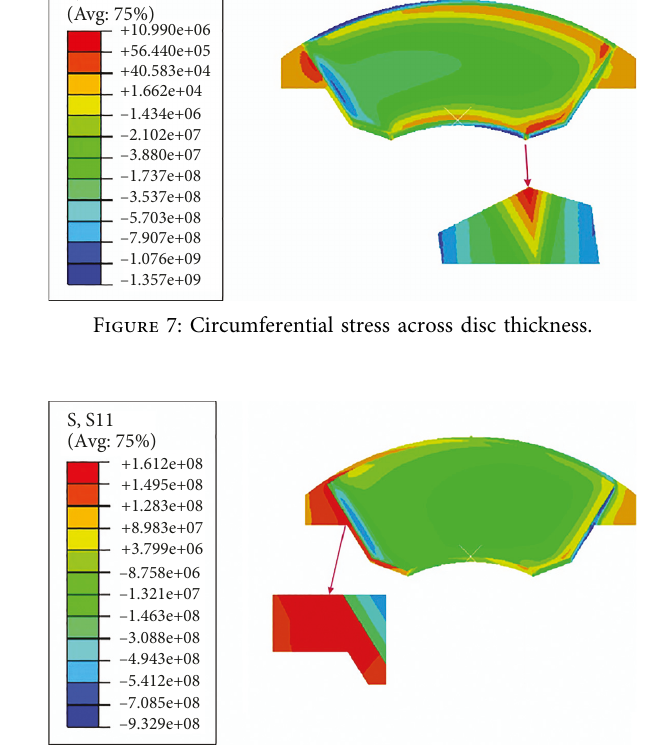
Figure 8: Contour plot of radial stress across disc